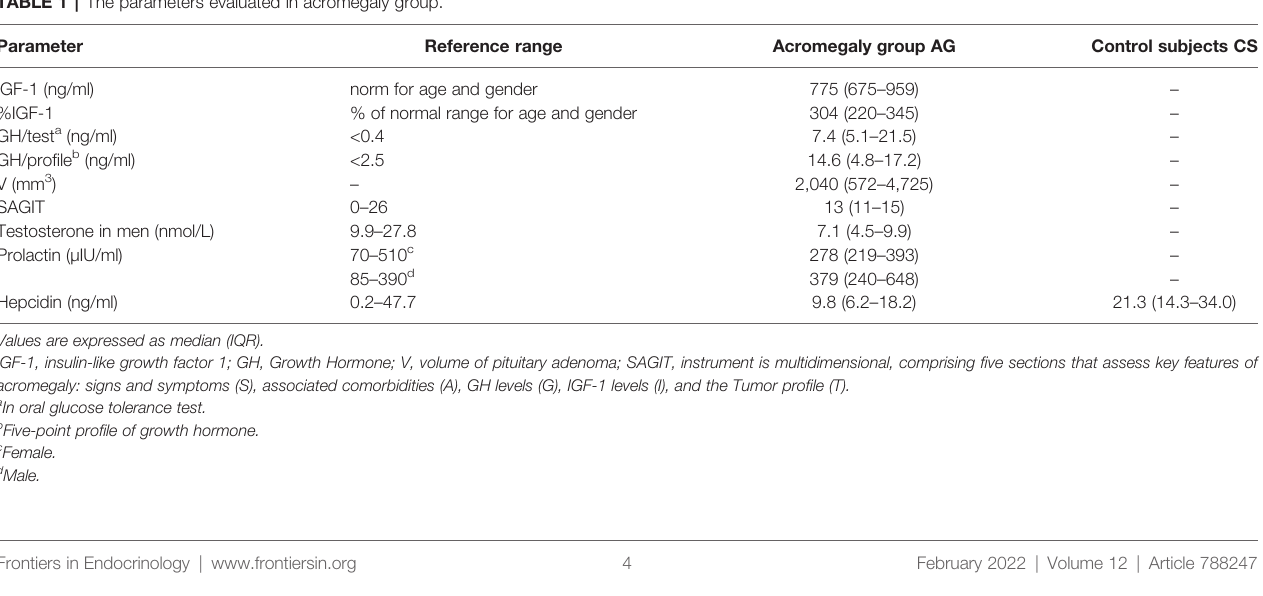
TABLE 1 | The parameters evaluated in acromegaly